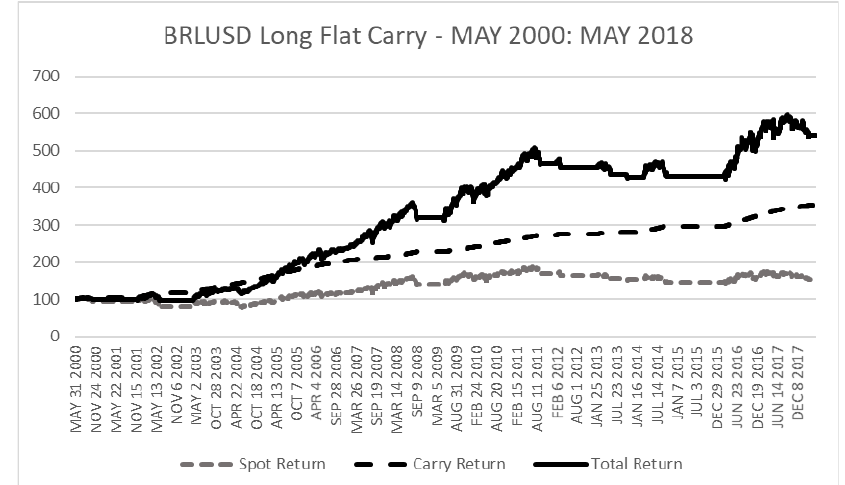
Figure 4 . BRLUSD Long Flat Carry. Source: Authors elaboration from financial series extracted from